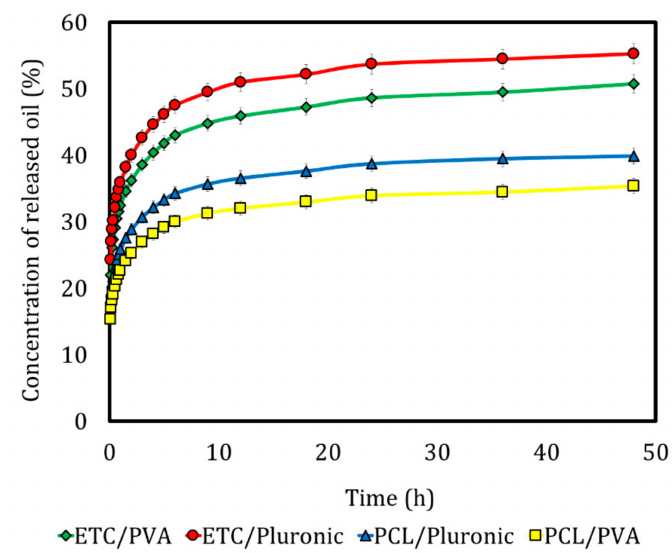
Figure 3. In vitro release profiles obtained for the di ff erent polymeric nanocapsules.